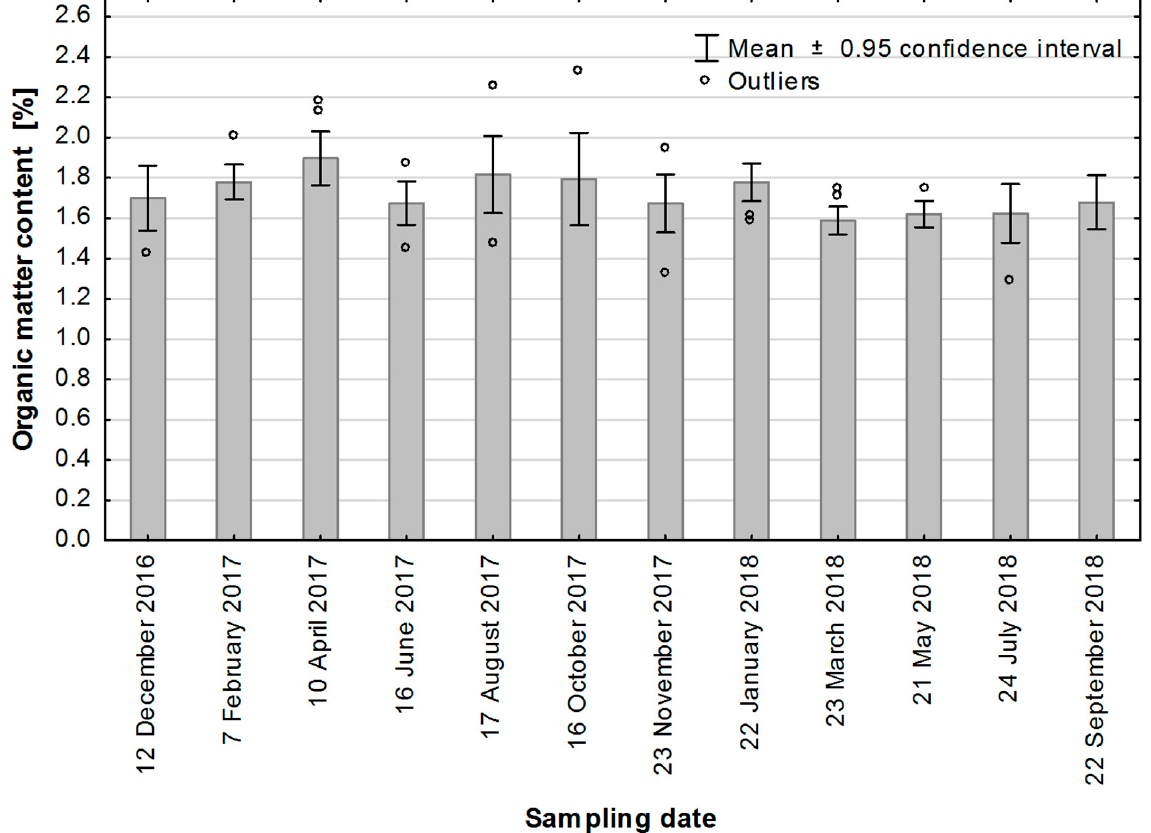
Figure A4. Organic matter content (%) in the field at sampling dates (n = 9). Whiskers represent confident intervals at 0.95 probability. Dots represent outliers i.e., values with dispersion over the mean larger than 1.5 interquartile range (IQR). Table A2. Soil oxidizable carbon (SOC) and organic matter (SOM) content in the soil samples. Soil Oxidizable Carbon (SOC) and Soil Organic Matter (SOM)